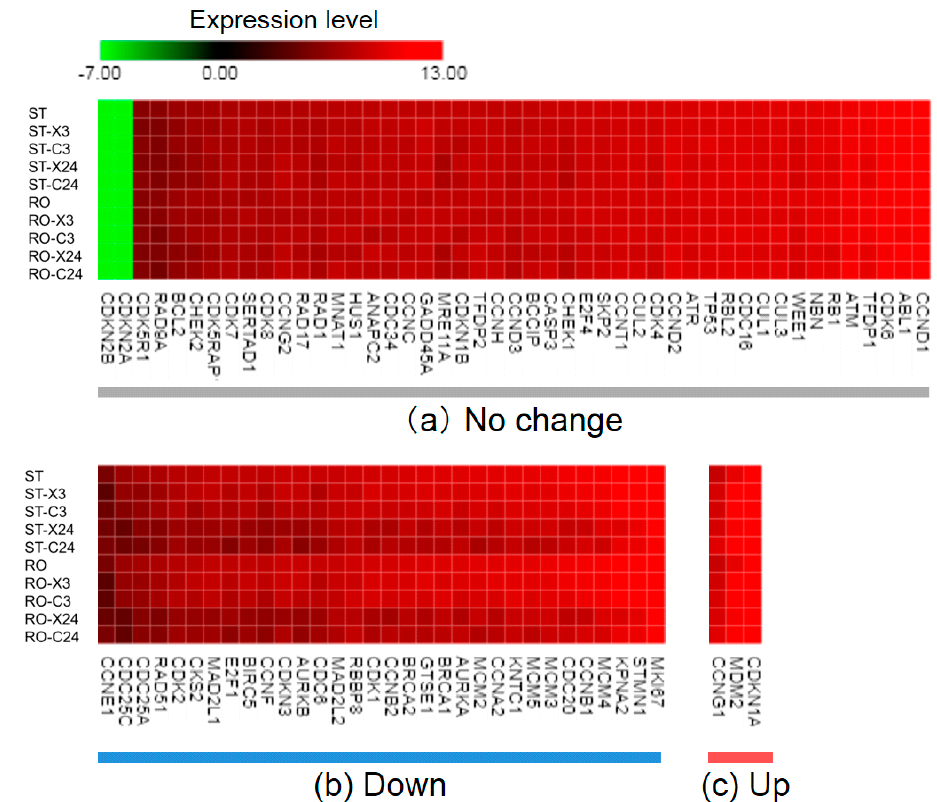
Figure 1. Heatmap of 82 cell cycle-related genes under various conditions. ST, standing 1 G ; RO, rotation for simulated µ G ; X, X-ray irradiation; C, carbon-ion irradiation; 3, 3 h after irradiation; 24, 24 h after irradiation. After treatment, a total of 36 samples was analyzed for each condition (ST or RO alone, N = 6; the other 8 conditions, N = 3). The range of expression levels was from − 7.00 (yellow-green, down-regulation) to 13.00 (red, up-regulation); black represents 0.00. When the di ff erence between the transformed expression value of a gene under each condition and that of ST was smaller than 1.0, the gene was allocated to the no change group ( a ). If the di ff erence was larger than 1.0, it was put into either the down-regulated ( b ) or up-regulated group ( c ).